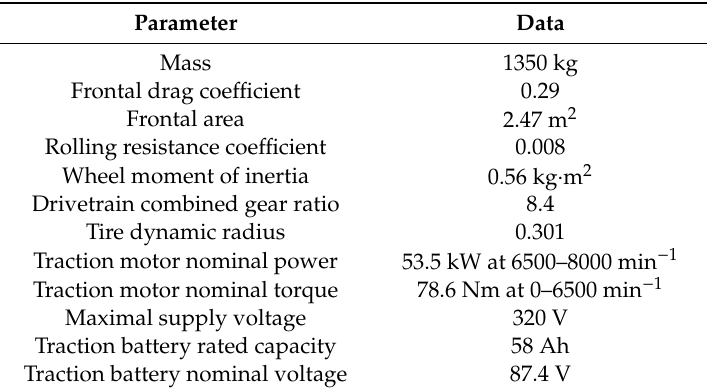
Table 5. Simulated vehicle